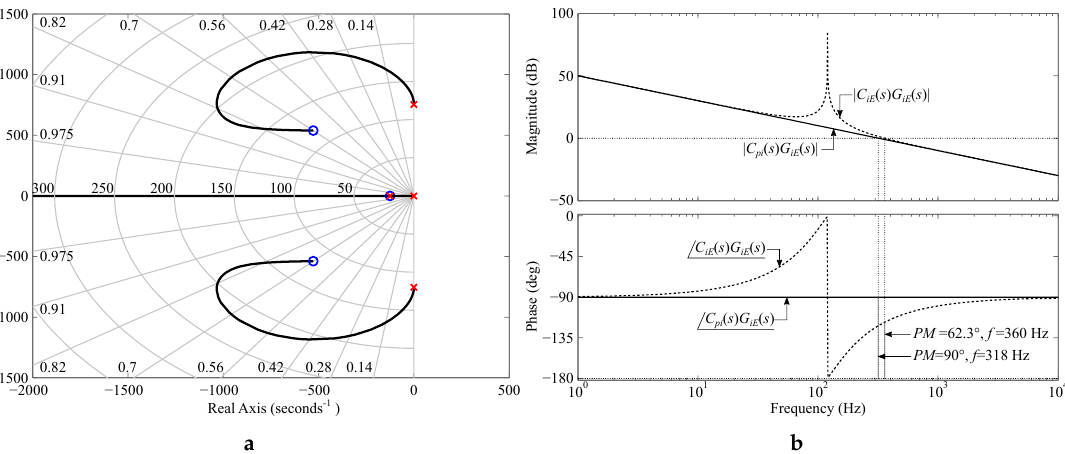
Figure 8. ( a ) Root locus of the open-loop transfer function C iE ( s ) G iE ( s ) . ( b ) Bode diagram of the open-loop transfer function considering only a PI controller and a PI+resonant control action.